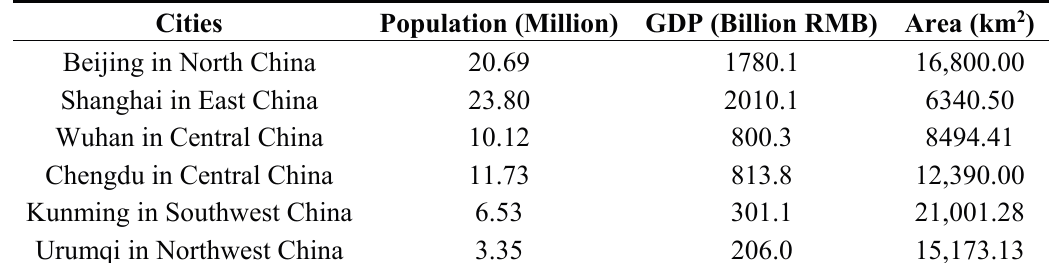
Table 1. Summary of populations, gross domestic products (GDPs), and total areas for the six cities.